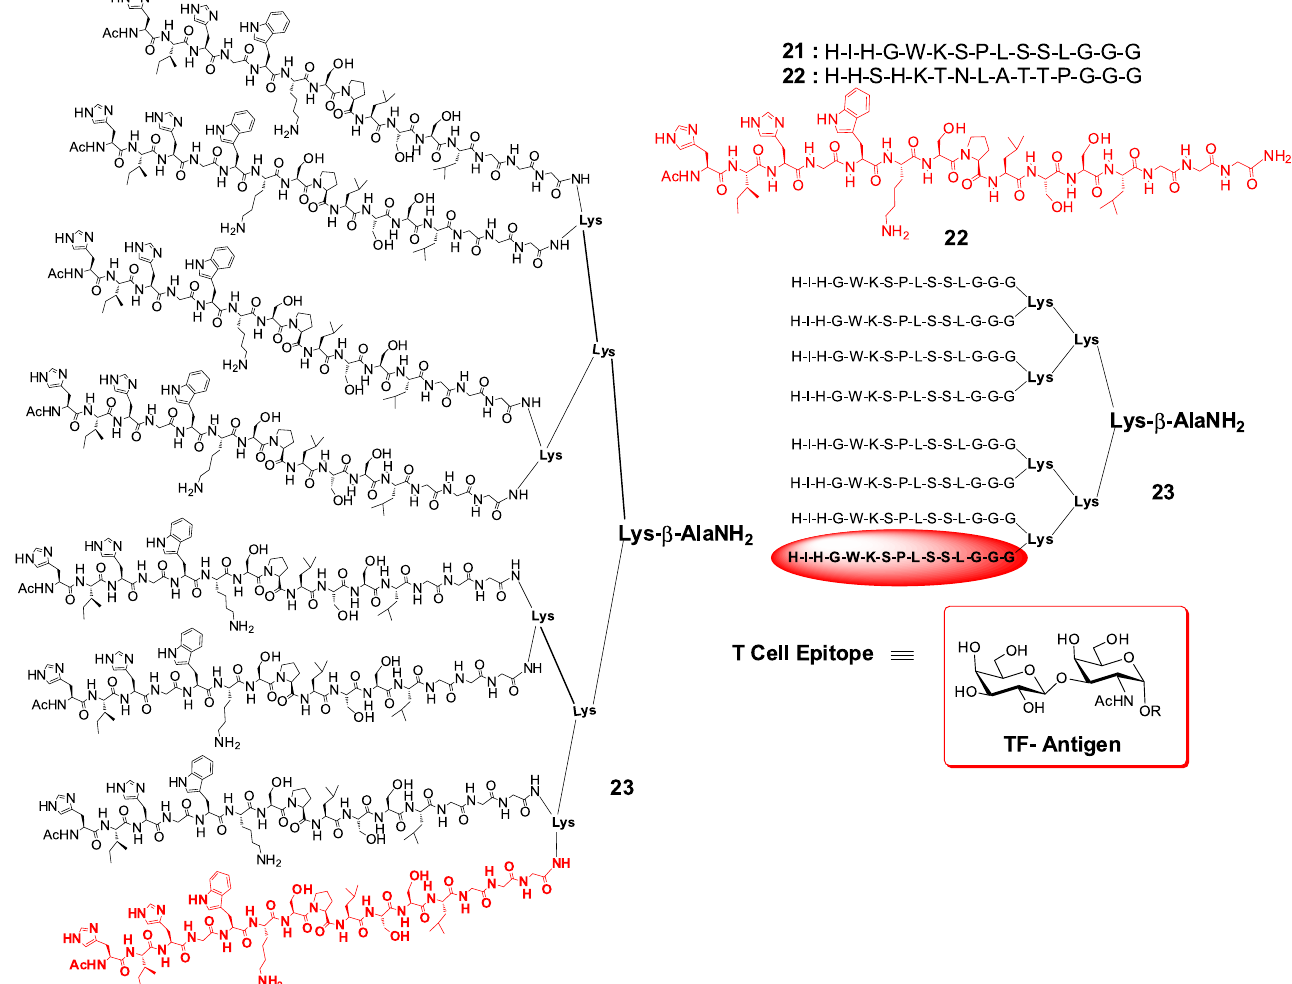
FIGURE 9 - Antigenic carbohydrate epitopes can be functionally replaced by peptide sequences. When multimerized into a dendritic molecular architecture, the resulting neoglycoconjugates can not only be recognized by anti-carbohydrate antibodies but can also act to trigger a successful immune